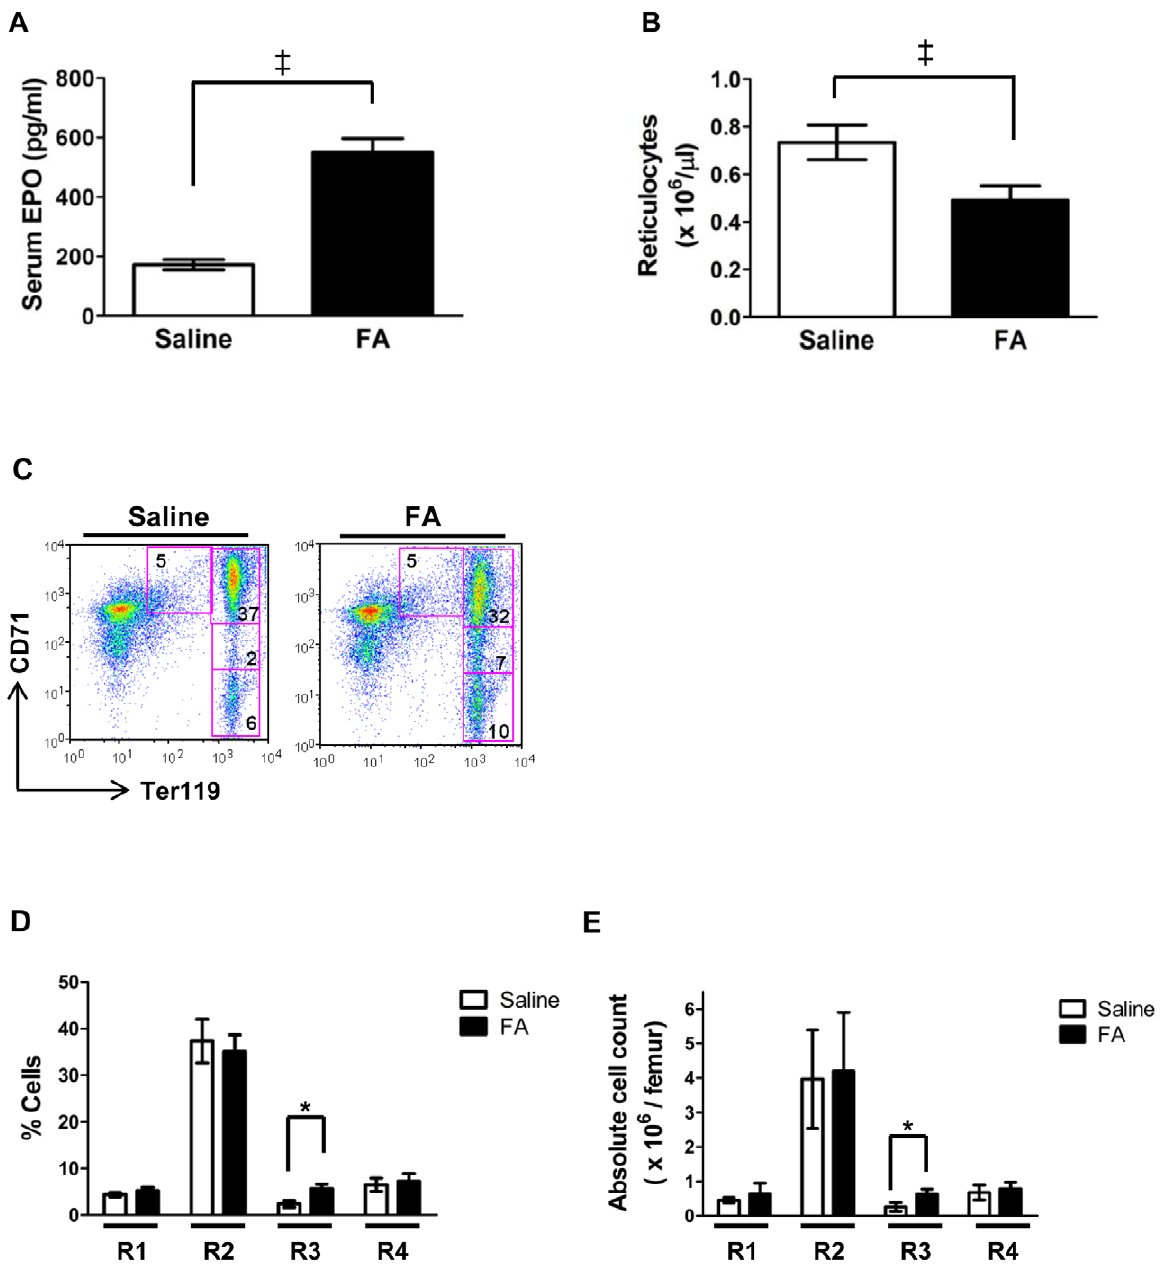
Figure 1. In vivo effects of aconitase inhibition. ( A ) Serum EPO levels in mice treated for 14 days with an infusion of saline (0.9%) or FA (4 mg/ kg/day). Data represent mean 6 SD; n=9 for saline group and 10 for FA group; { P , 0.001. ( B ) Absolute reticulocyte counts in mice treated as in panel A . Data represent mean 6 SD; n=10 per group; { P , 0.001. ( C ) Erythroid maturation in marrows from mice who received a four-week infusion of FA (2 mg/kg/day) or saline (0.9%). Representative flow cytometry plots are shown. Boxes indicate erythroid developmental stages R1–R4, from top left (R1) to bottom right (R4). ( D ), ( E ) Summary of data from panel C displayed as cell percentages ( D ) or absolute cell numbers per femur ( E ) in regions R1–R4. Data is presented as mean 6 SD; n=4 per group; * P ,